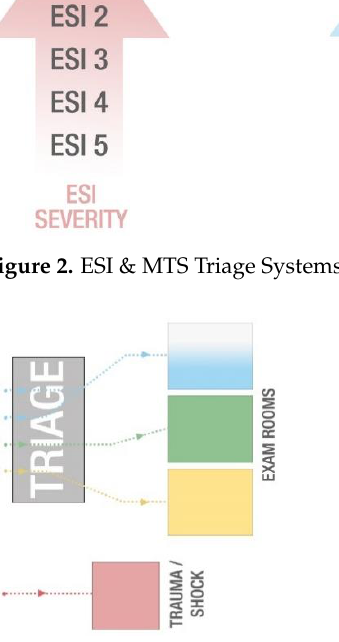
Figure 3. Italian HBED Triage and Layout Organization.